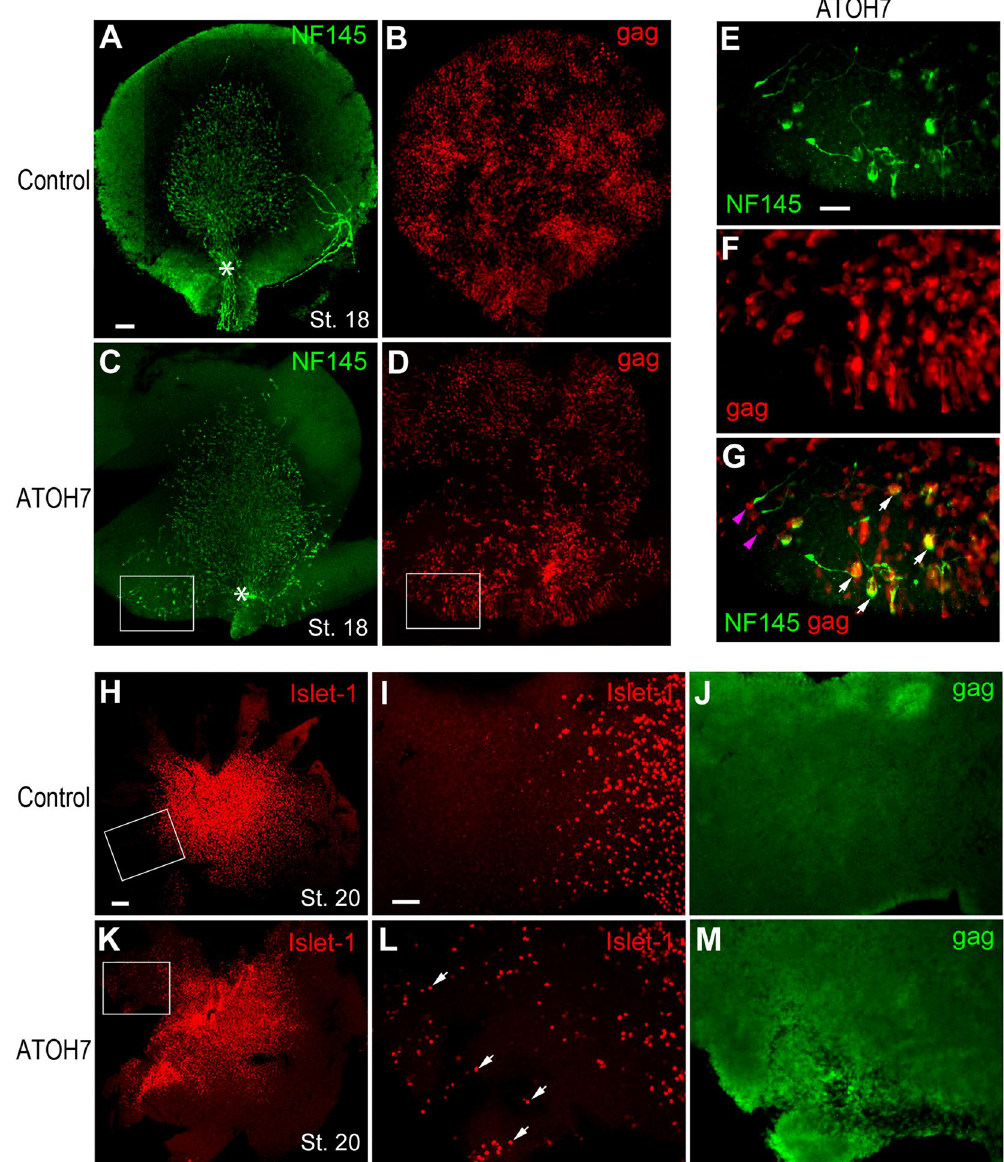
Figure 1. Induction of precocious retinal ganglion cell production by human ATOH7. ( A – D ) Immunofluorescent images of flat mount stage 18 retinas infected at stage 10 with the control virus ( A , B ) or ATOH7 virus ( C , D ) and co-labeled for NF145 ( A , C ) and viral gag protein ( B , D ). ( E – G ) show magnified and merged ( G ) images of the framed areas in the ATOH7 virus infected retina ( C , D ). White arrows in ( G ) point to ATOH7-induced ectopic RGCs co-labeled for NF145. Purple arrowheads in ( G ) indicate viral infected cells that did not express NF145. Note all NF-positive growth cones in ( E ) show abnormal projections away from the optic nerve head (white asterisks in A , C ). ( H–M ) Immunofluorescent images of flat mount stage 20 retinas infected at stage 10 with the control virus ( H–J ) or ATOH7 virus ( K – M ) and co-labeled for Islet-1 ( H , I , K , L ) and viral gag protein ( J , M ). Framed areas in ( H , K ) are magnified in ( I , J ) and ( L , M ), respectively. Note that due to viral spread in the retinas ( J , M ), gag labeling no longer show individual infected cells. White arrows in ( L ) point to ATOH7-induced ectopic RGCs. Scale bars: A (for A – D ), 20 μ m; E (for E – G ), 10 μ m; H (for H , K ), 50 μ m; I (for I , J , L , M ), 20 μ